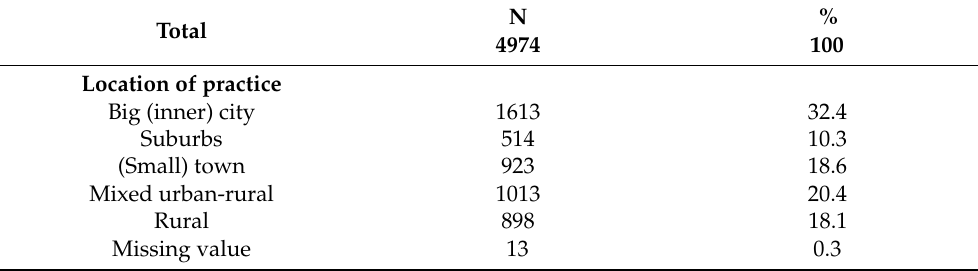
Table 1. Main characteristics of the practices participating in the